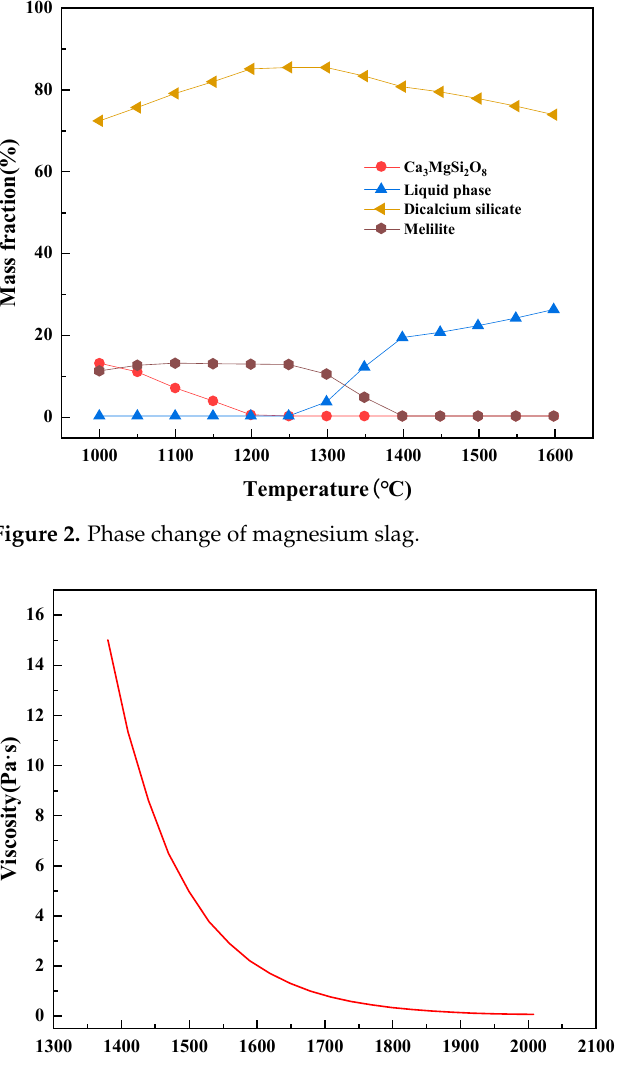
• (b) Figure 1. Phase analysis of magnesium slag: ( a ) magnesium slag A, ( b ) magnesium slag B.